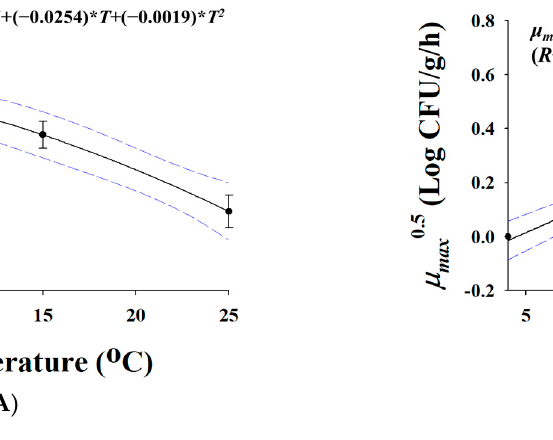
Figure 3. Salmonella lag phase ( A ) and growth rate ( B ) as a function of distribution temperature. Symbol, observed value; line, polynomial-fitted line. ( A ) ln( LPD ), ( B ) (cid:3493)𝜇 (cid:3040)(cid:3028)(cid:3051) . Table 1. Baranyi model kinetic parameters for Salmonella spp. in chicken and